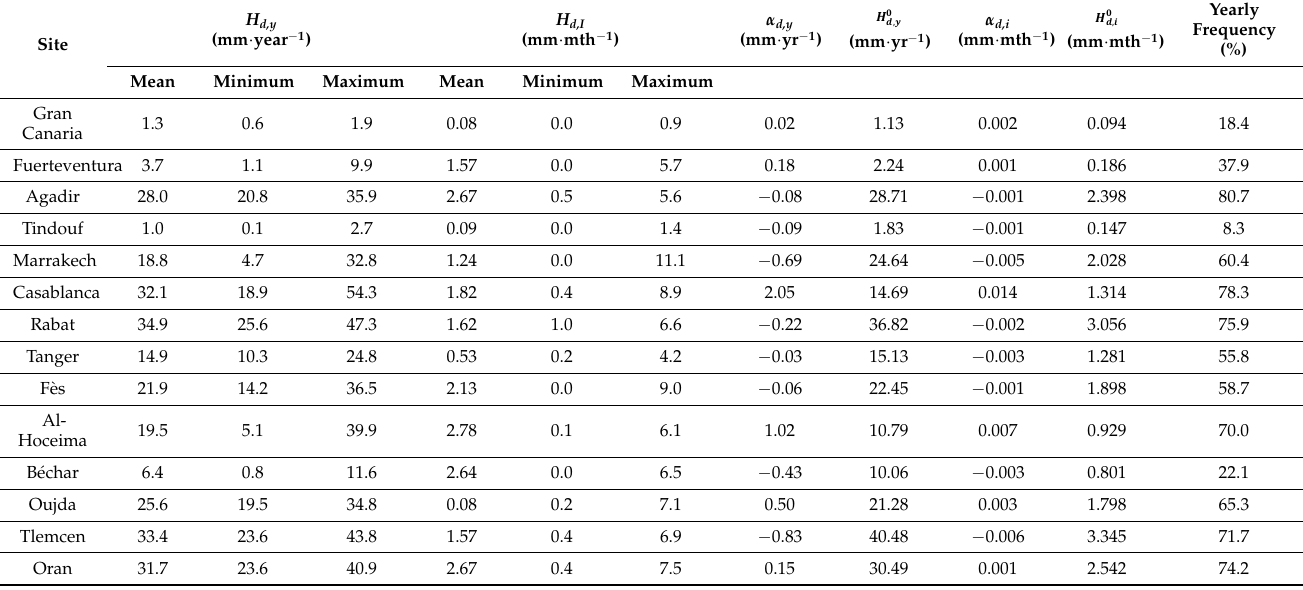
Table 3. Monthly ( H d,i ) and yearly ( H d,y ) dew yields calculated from meteorological data. Mean (arithmetic, with H d , y = 12 H d , i ), minimum and maximum values are reported for the 16 years period 2005–2020. The evolution of the yearly and monthly mean values is fitted to Equation (14) with α d , y and H 0 (yearly means) and α d , i and H 0 (monthly means) as free parameters. The red values correspond to a decrease, blue values to an increase.